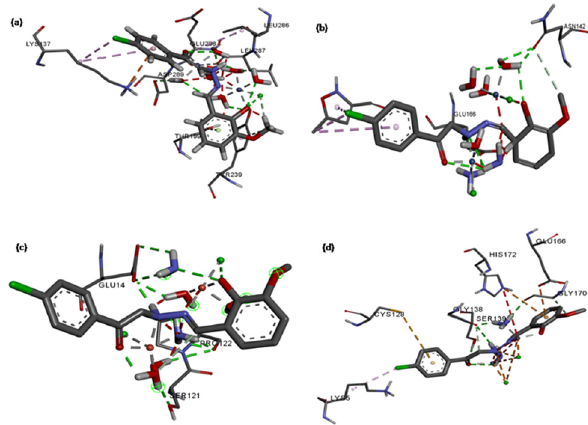
Figure 10: 3Dinteractiondiagramshowingthedockinginteractionsof ( a ) Co ( II ) , ( b ) Ni ( II ) , ( c ) Cu ( II ) , and ( d ) Zn ( II ) complexes with COVID - 19 ( 6LU7 )